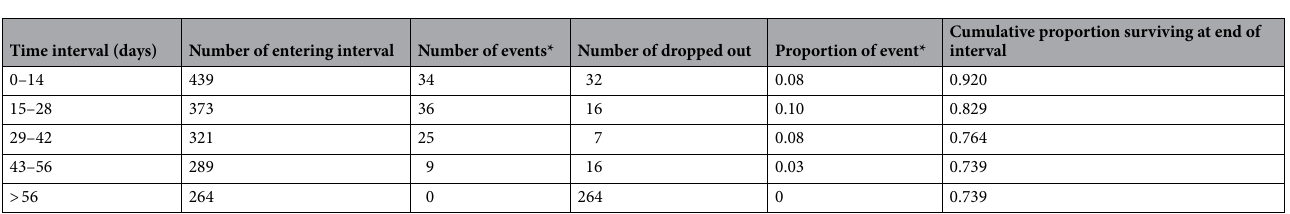
Table 1. Life table of early treatment interruption among newly diagnosed pulmonary TB smear-positive patients in urban districts, Selangor (n = 439). *Event: early treatment interruption.